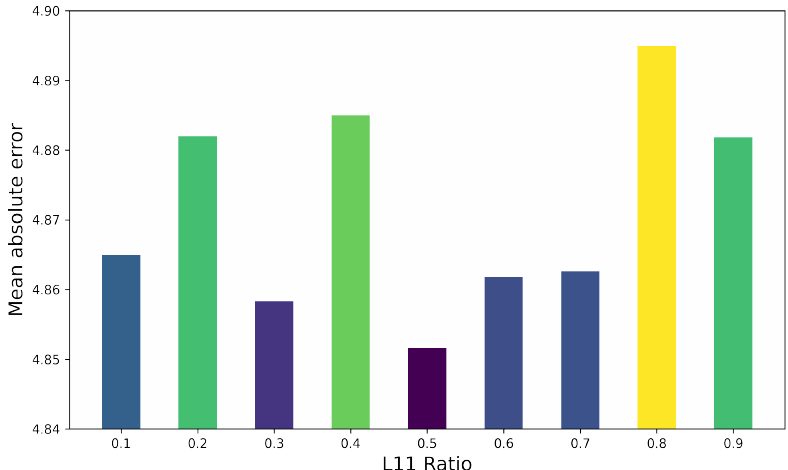
Figure 7. Impacts of L11 ratio on Concrete dataset.